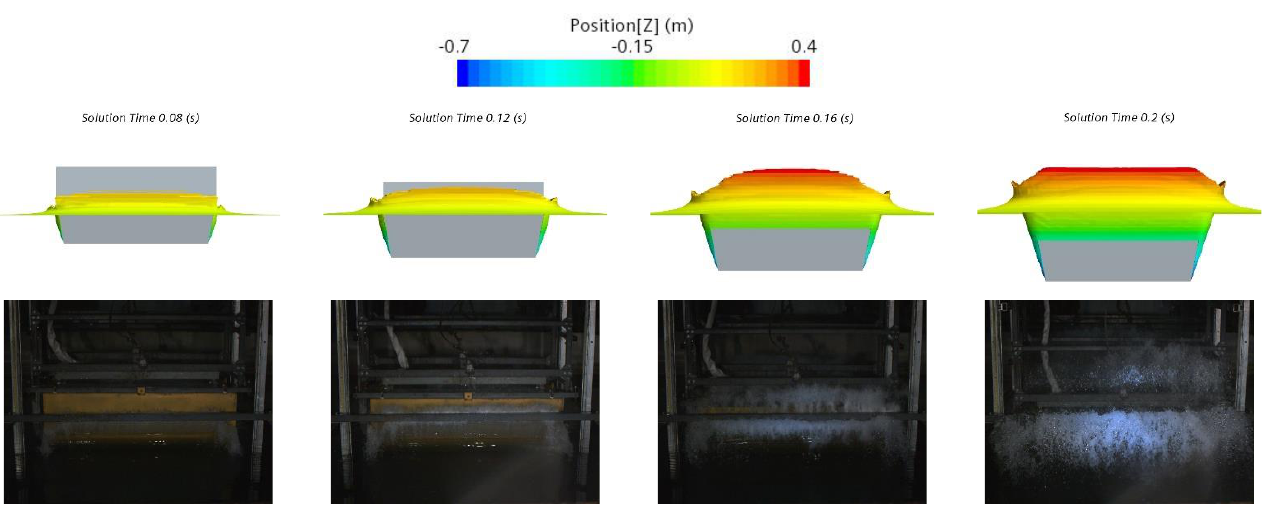
Figure 17. Comparison of experimental and numerical flow phenomena at different times (Case 4).